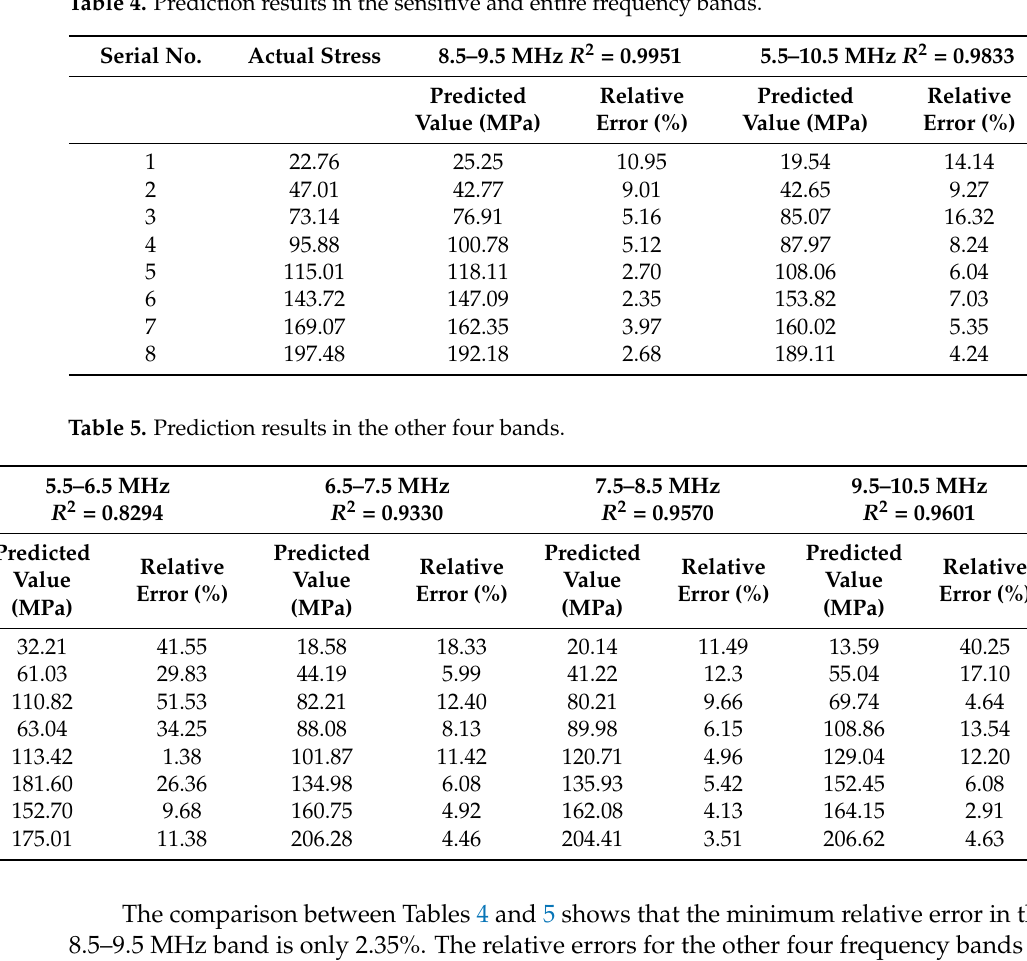
Table 4. Prediction results in the sensitive and entire frequency bands.